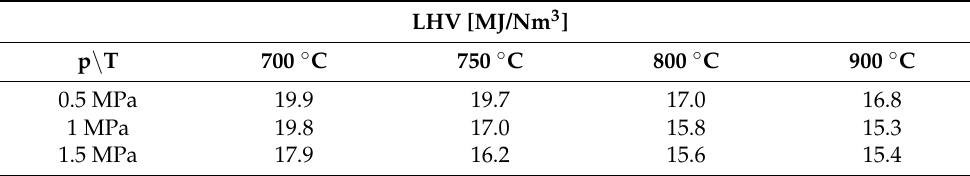
Table 4. The LHV of gas from CO 2 gasification of RDF.